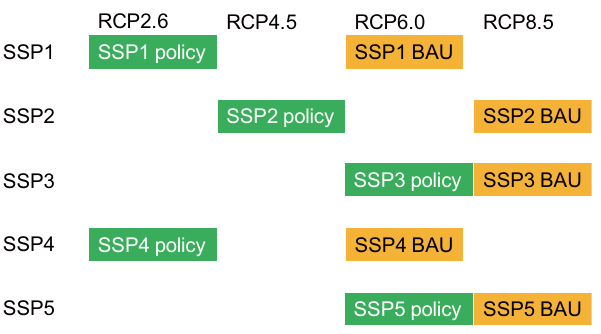
Fig. 3. Scenario matrix of SSPs and